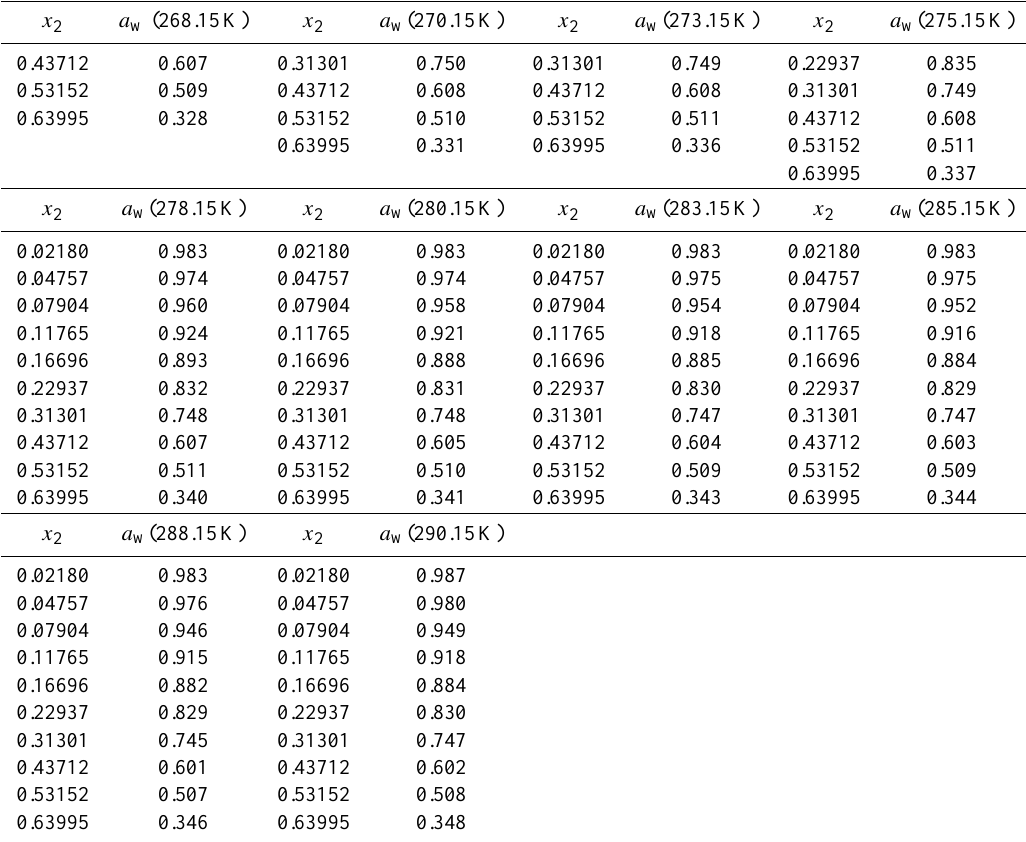
Table 13. Measured water activities of water (1)+methoxyacetic acid (2) mixtures derived from total gas phase pressure measurements ∗ , listed for a selection of temperatures in the range 268K <T < 291K. Solution compositions are given in mole fractions of the organic (x 2 ) . x